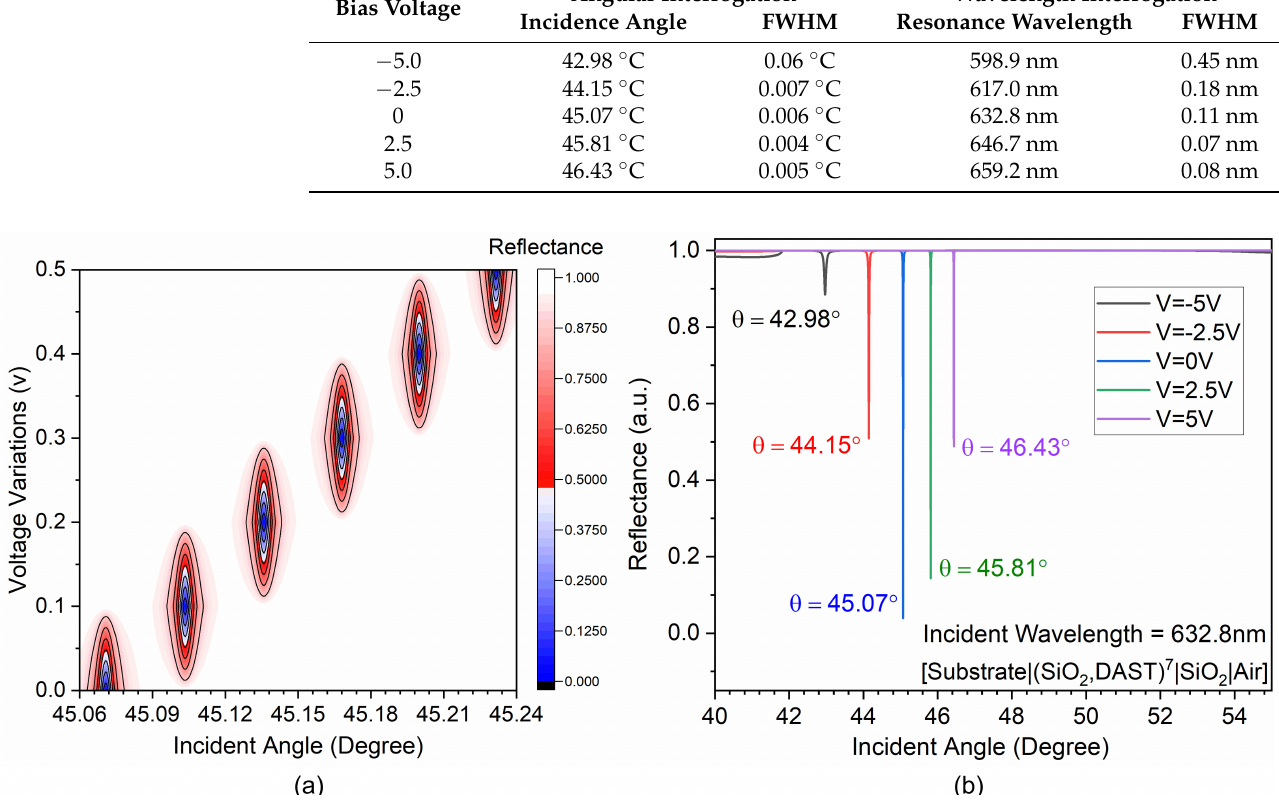
Figure 6. The impact of voltage variation on the reflectance spectrum for a constant incident wave- length of 632.8 nm at an applied voltage of: ( a ) 0 V to 0.5 V; and ( b ) for − 5.0 V to 5.0